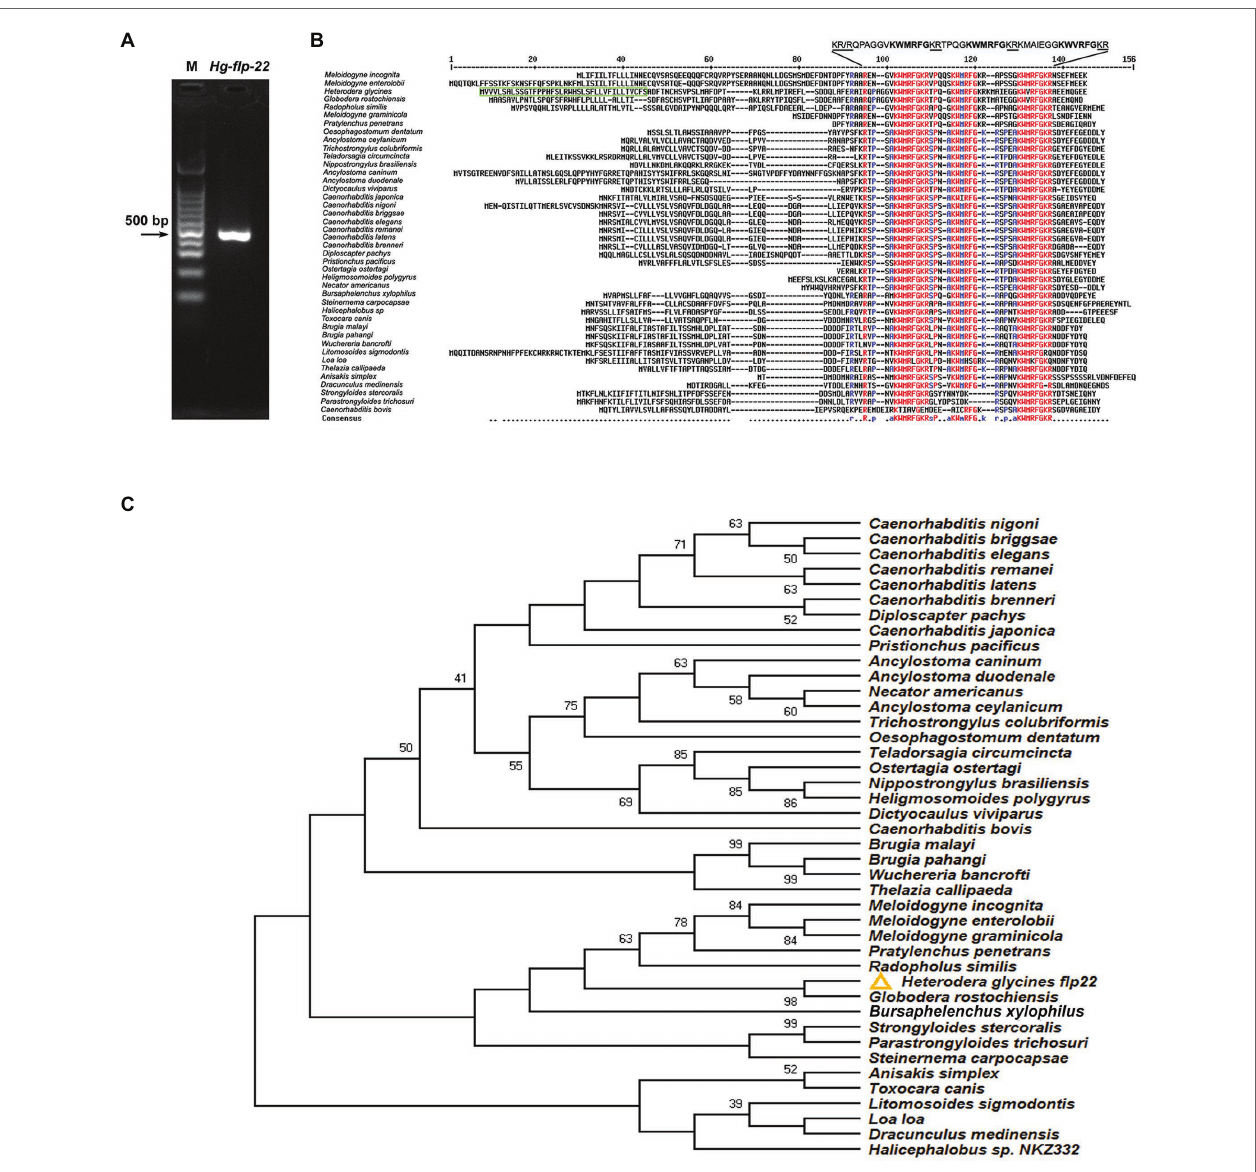
FIGURE 1 | (A) PCR amplification of flp-22 cDNA fragment of Heterodera glycines . M: 100 bp marker. (B) Multiple sequence alignment of FLP-22 peptide from H. glycines (GenBank Accession No. MW645239) with homologs from other nematode species using MULTALIN online tool (http://multalin.toulouse.inra.fr/multalin/). The predicted signal peptide of Hg-FLP-22 is marked by a green box. Residues identical to those of FLP-22 are indicated by the identical color of amino acids. Conserved Hg-FLP-22-like motifs are flanked by mono (R) or dibasic (KR) cleavage sites. (C) Phylogenetic tree of nematode flp-22 genes. Putative FLP-22 peptides from H. glycines and other 41 nematode species were obtained with BLAST using Hg-flp-22 sequence as a query. The evolutionary tree was generated by using the Neighbor-Joining method based on Poisson distance correction. The bootstrap analysis consisted of 1,000 replicates, and the cutoff value for a condensed tree was